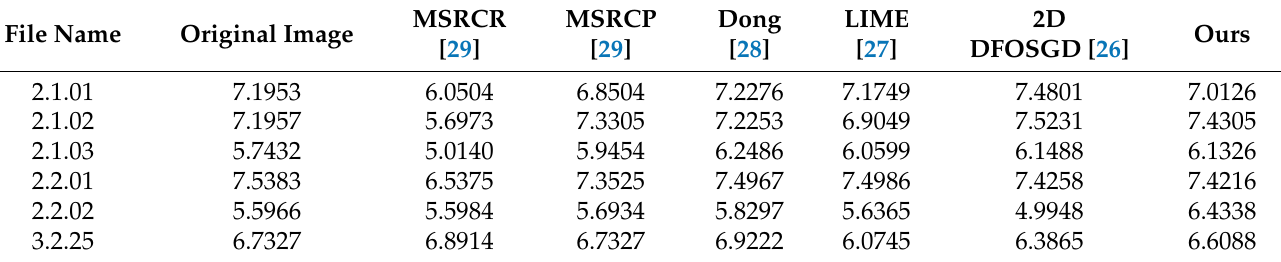
Table 1. The comparison of information entropy.